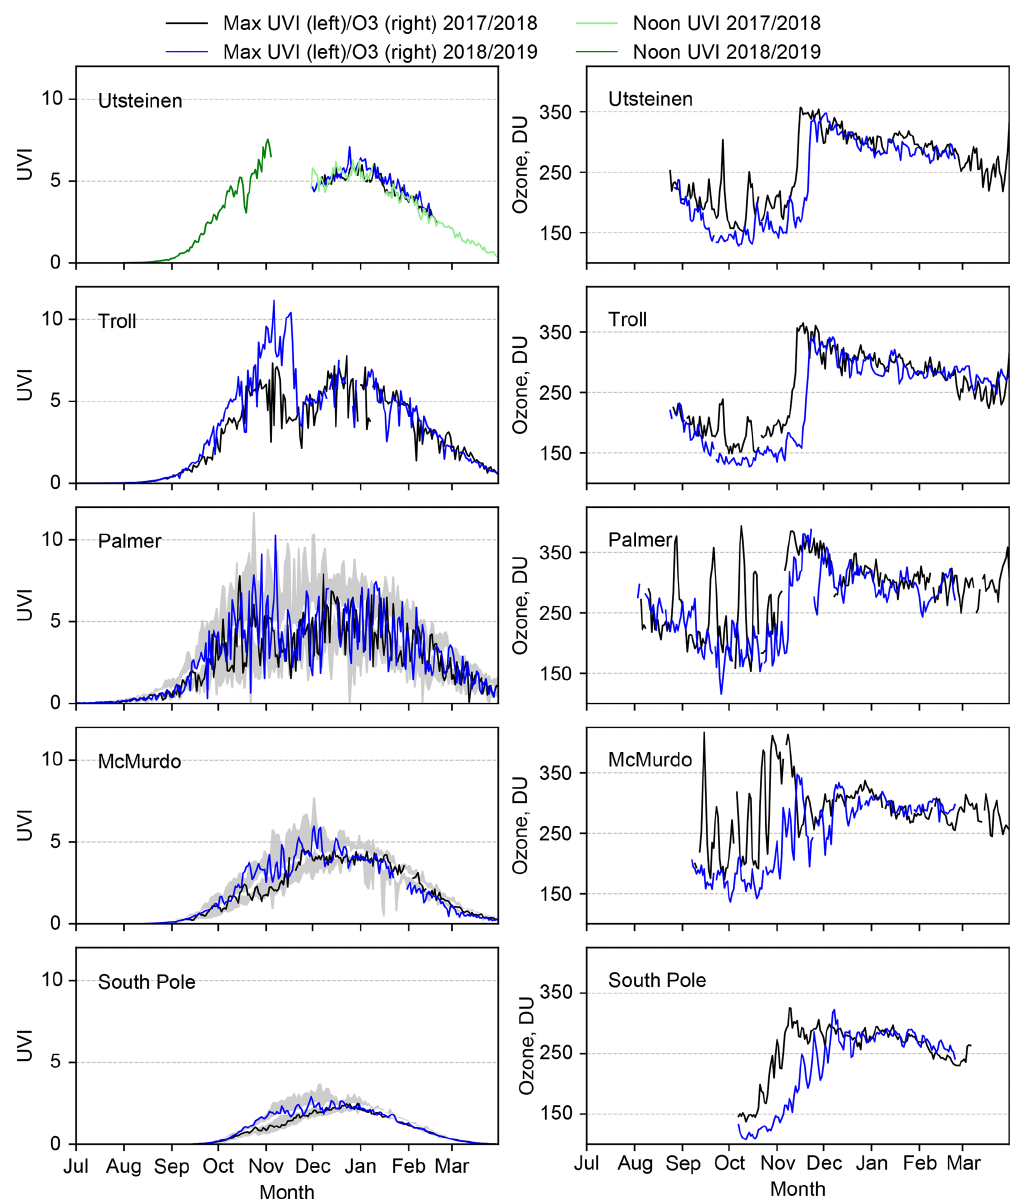
Figure 10. Maximum daily UVI (left) and daily TOC (right) for different Antarctic stations for 2017/2018 (black line) and 2018/2019 (blue line). In the Utsteinen UVI plot, noon UVI values (2017/2018 – light green, 2018/2019 – dark green) have been added to get longer time series. In the plots of UVI in Palmer Station, McMurdo Station and South Pole Station, the long-term (2000–2008) averages (white line) and variations (grey area) have been